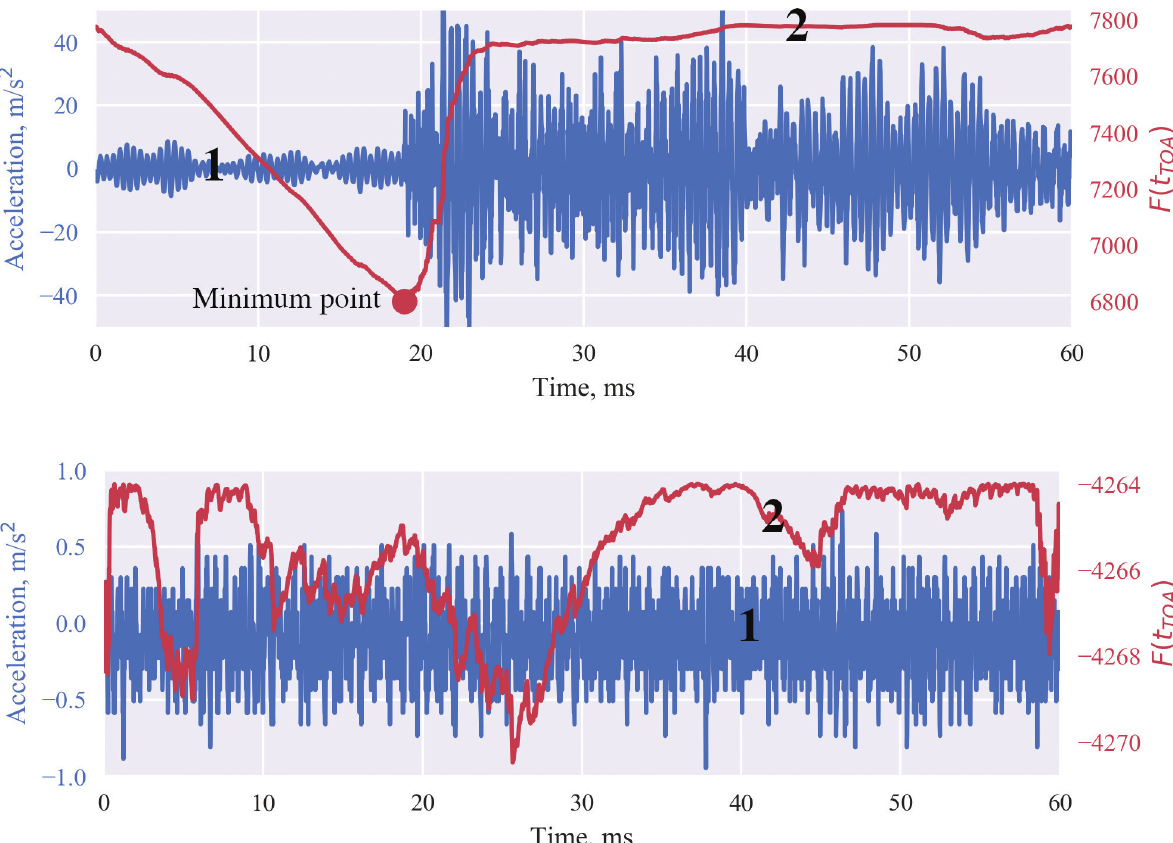
Figure 1. Estimation of the time of arrival of the acoustic signal: a) with an acoustic effect; b) without an acoustic effect (1 – signal, 2 – objective